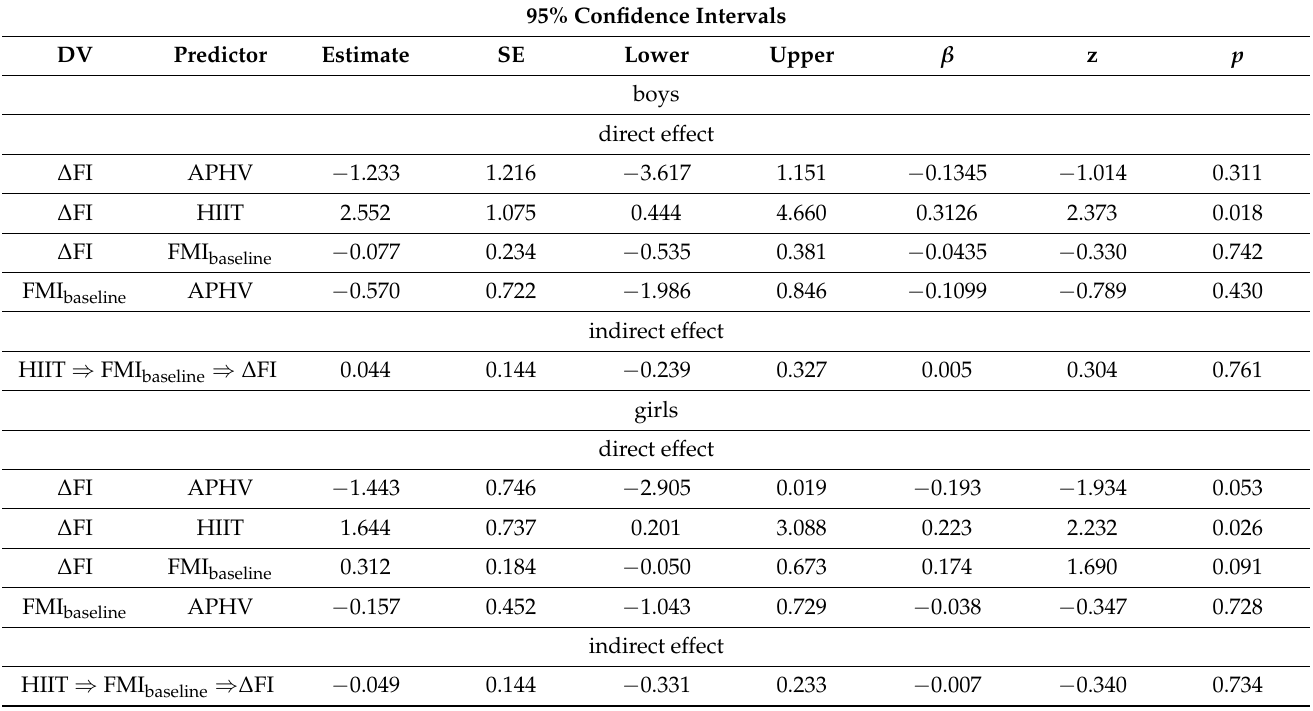
Figure 2. Path models, constructed for males and females, show the association between changes in FI and APHV, HIIT intervention, and sex as exogenous variables with the preintervention FMI. Ab- breviations: APHV—age at peak height velocity, HIIT—HIIT groups (EG−1 coded, CG-0 coded), Table 3. Direct and indirect effects of APHV, HIIT, preintervention FMI on ∆ FI in boys and girls. 95% Confidence Intervals